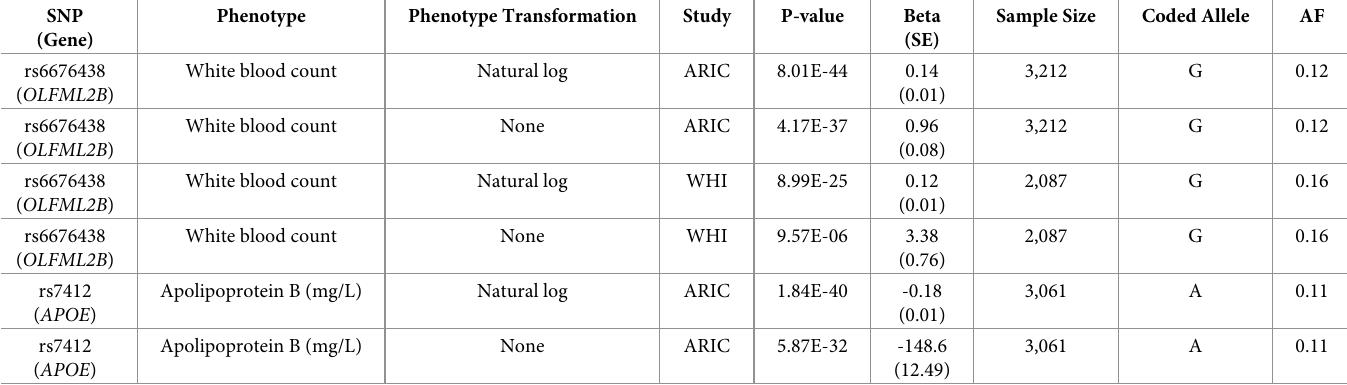
Table 2. Most significant and previously reported genotype-phenotype associations identified in the Population Architecture using Genomics and Epidemiology (PAGE) I study. Presented are the two most significant individual-level results for this PheWAS, along with other highly significant results for the same phenotype with a different transformation and/or study where the phenotype was available. Abbreviations: allele frequency (AF), standard error